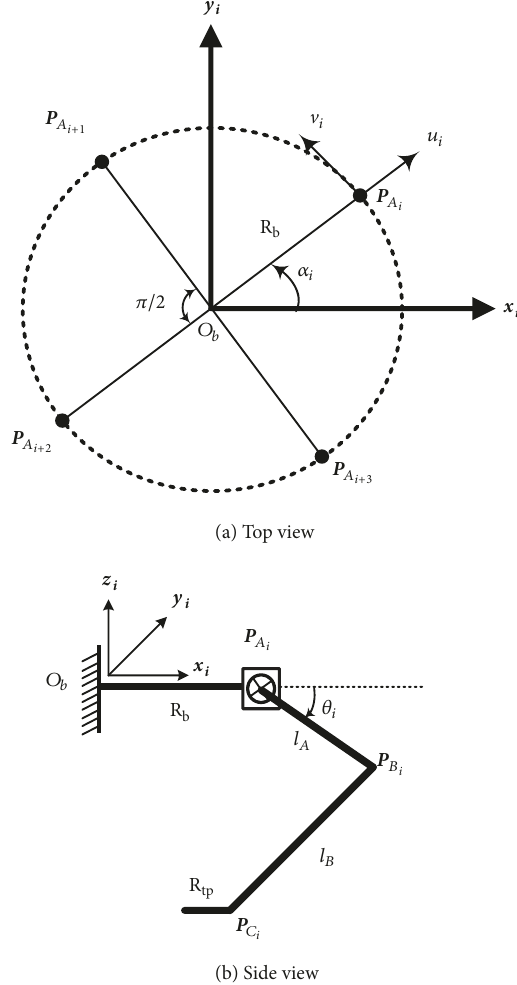
Figure 2: Geometric parameters of Delta/Par4-like